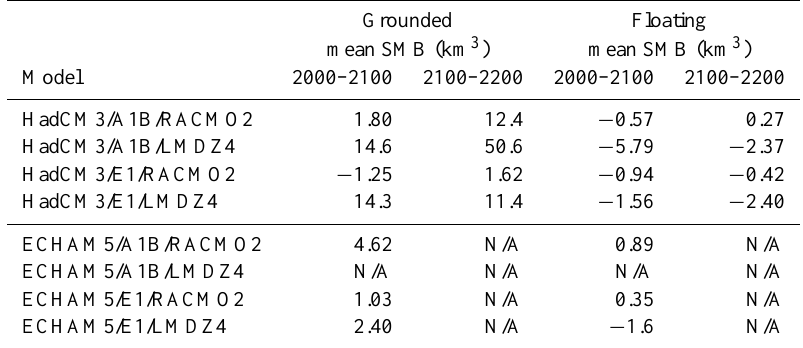
Table 1. The 21st and 22nd century mean surface mass balance anomalies with respect to the 1980–1990 mean, integrated over the present- day drainage basin